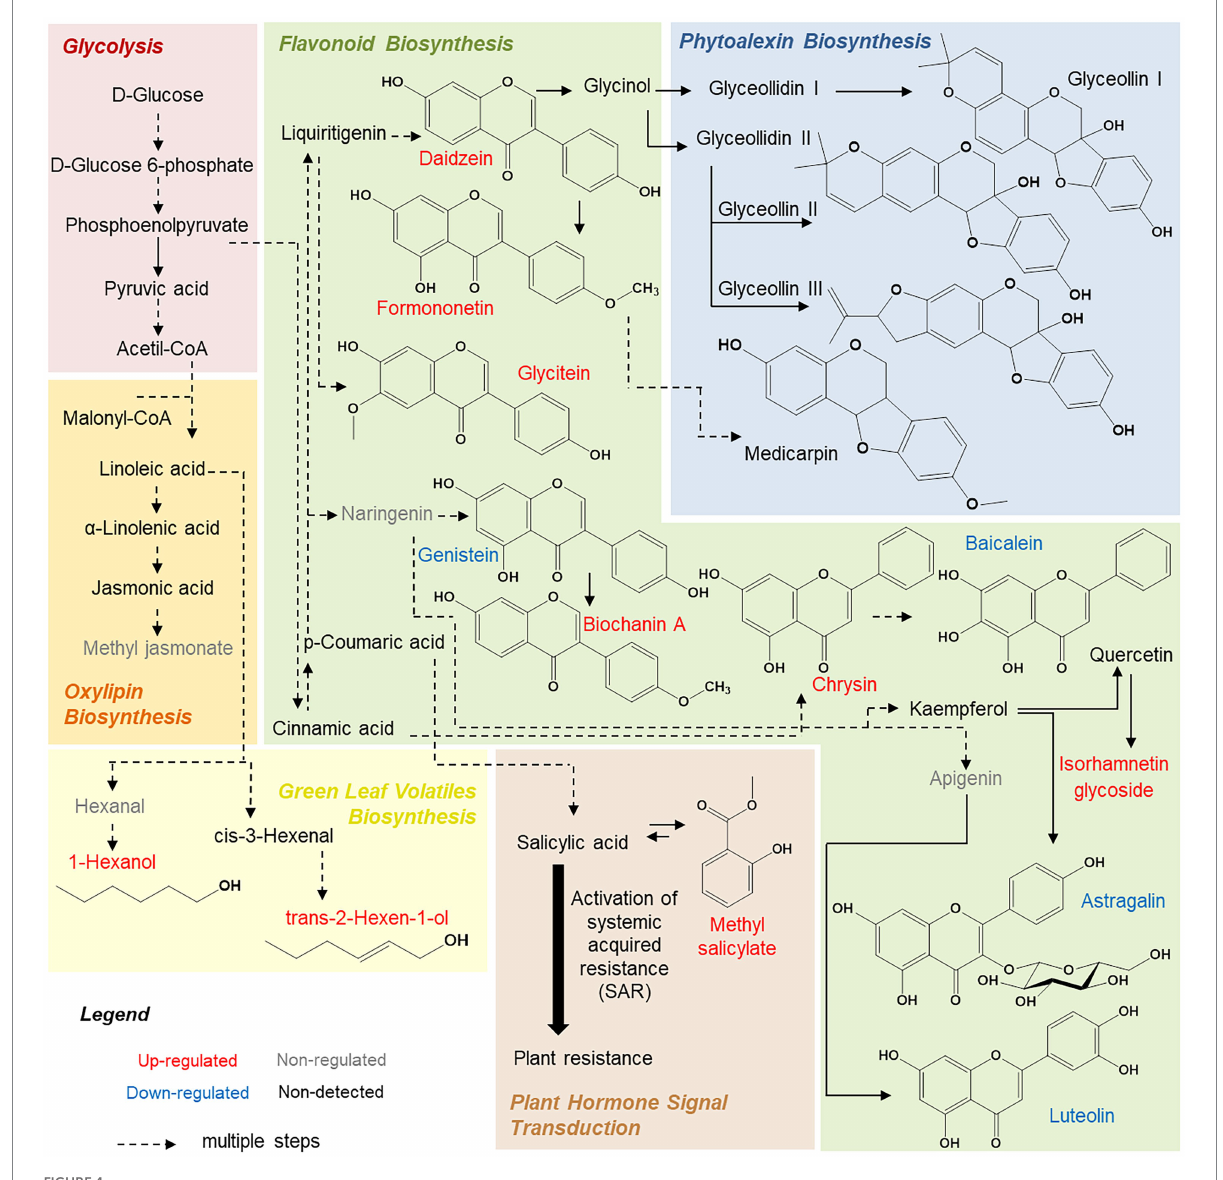
FIGURE 4 Summary of metabolic pathways predicted from changes in Glycine max leaf chemical